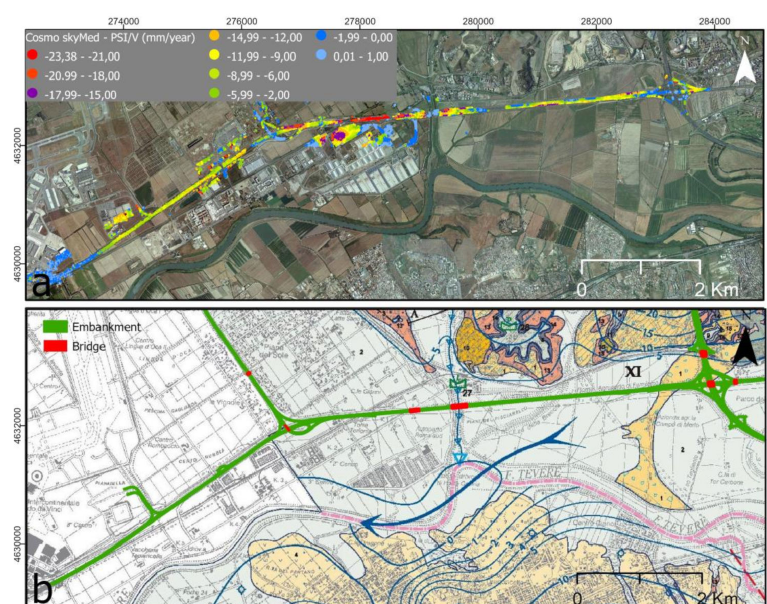
Figure 13. ( a ) Displacement map PSI Cosmo-SkyMed for Rome-Fiumicino, as background orthophoto Rome 2011, ( b ) Detail of the position of the A91 highway on the hydrogeological map of Rome (La Vigna et al., 2015) shows the position of the route in the alluvial deposit, indicates the flow of groundwater (blue arrow), indicates anthropogenic material due to hydraulic recovery works (mixed co ff ee).